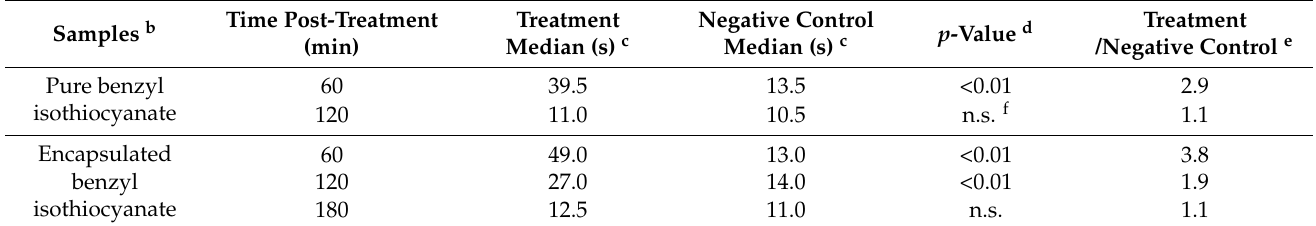
Table 3. Repellent effects of pure and encapsulated benzyl isothiocyanate against Haemaphysalis longicornis nymphs using a filter paper bioassay a